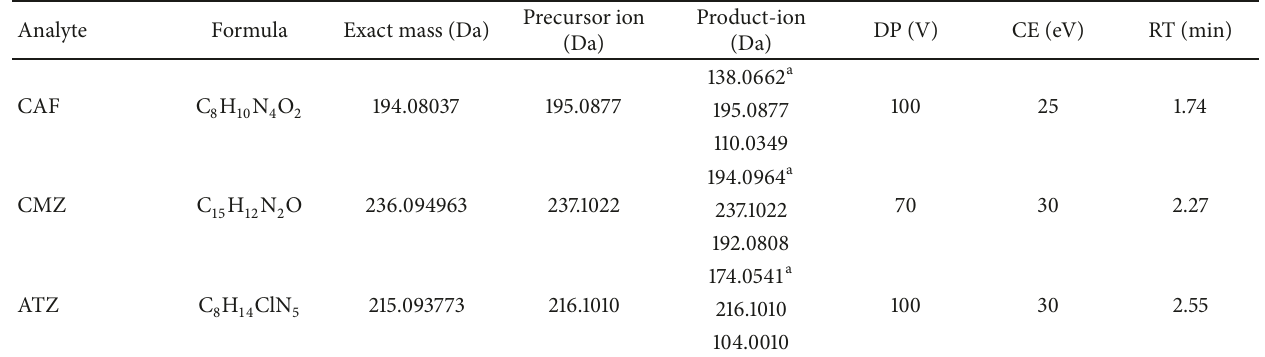
Table 2: Acquisition parameters used in the UPLC-QTO/MS